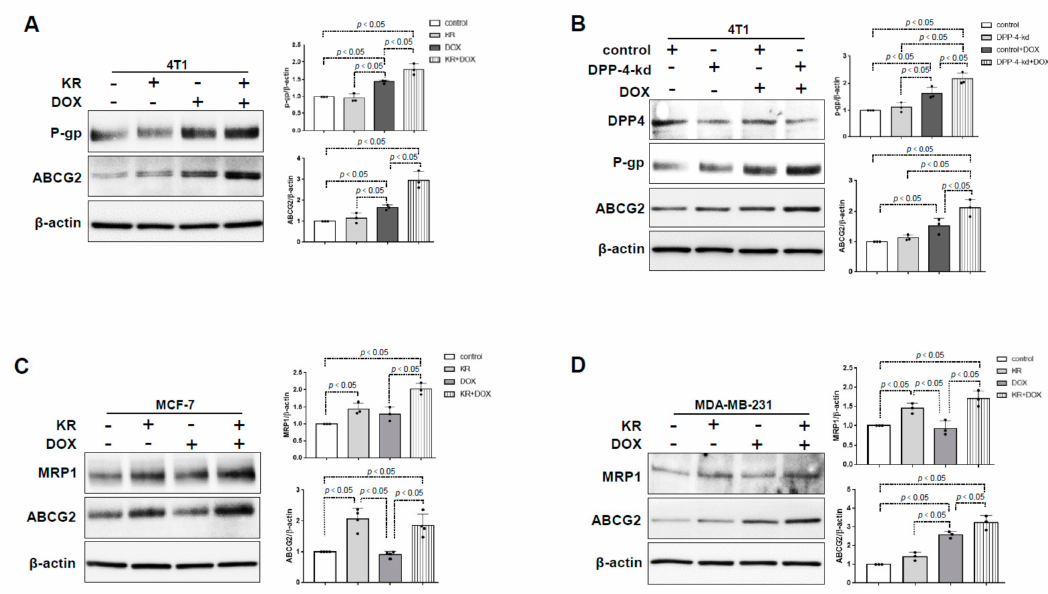
Figure 1. DPP-4 suppression enhanced the expression of ATP-binding cassette (ABC) transporters in breast cancer cells treated with chemotherapy drugs. ( A ) Western blot analysis of P-gp and ABCG2 in 4T1 cells pretreated with KR62436 (50 µ mol / L) for 48 h and then treated with or without doxorubicin (DOX;0.425 µ mol / L) for another 48 h. ( B ) Western blot analysis of P-gp and ABCG2 in DPP-4 shRNA knockdown (DPP-4-kd) and shRNA control (control) 4T1 cells treated with or without DOX (0.425 µ mol / L) for 48 h. ( C , D ) Western blot analysis of MRP1 and ABCG2 in MCF-7 cells ( C ) and MDA-MB-231 cells ( D ) pretreated with KR62436 (50 µ mol / L) for 48 h and subsequently treated with or without DOX (0.425 µ mol / L) for another 48 h. All representative blots from three independent experiments were shown, and densitometric analysis of protein expression relative to β -actin levels was performed by using